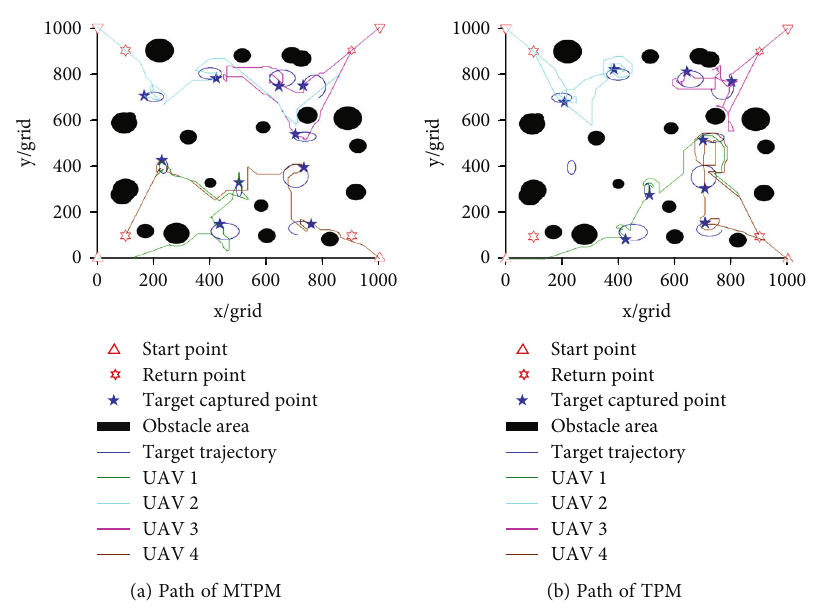
Figure 4: The cooperative search